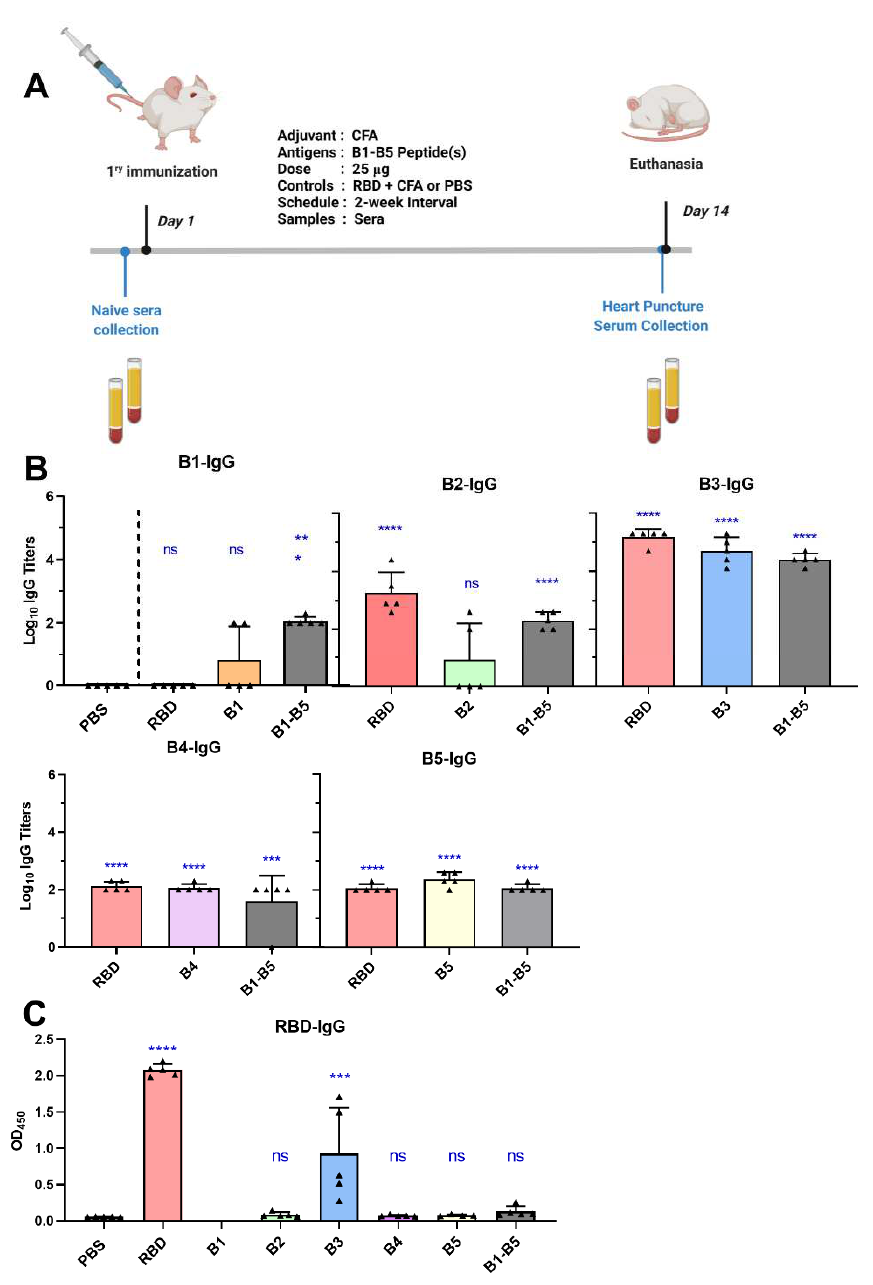
titers in the serum after two immunizations. CFA-adjuvanted RBD mouse serum generated significant anti-B2 IgG titers (log 10 = 3, p < 0.0001) in the serum (Figure S4).